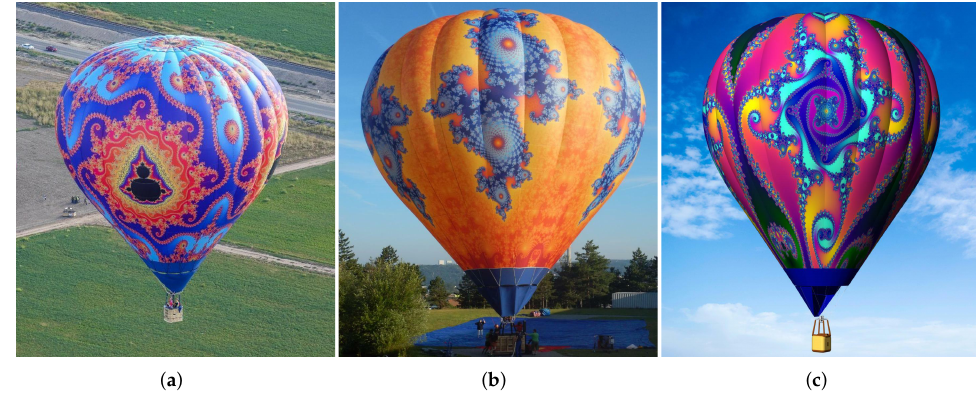
Figure 31. Fractal Balloons: ( a ) Infinitude, ( b ) Fibonacci, and ( c ), a Future balloon.